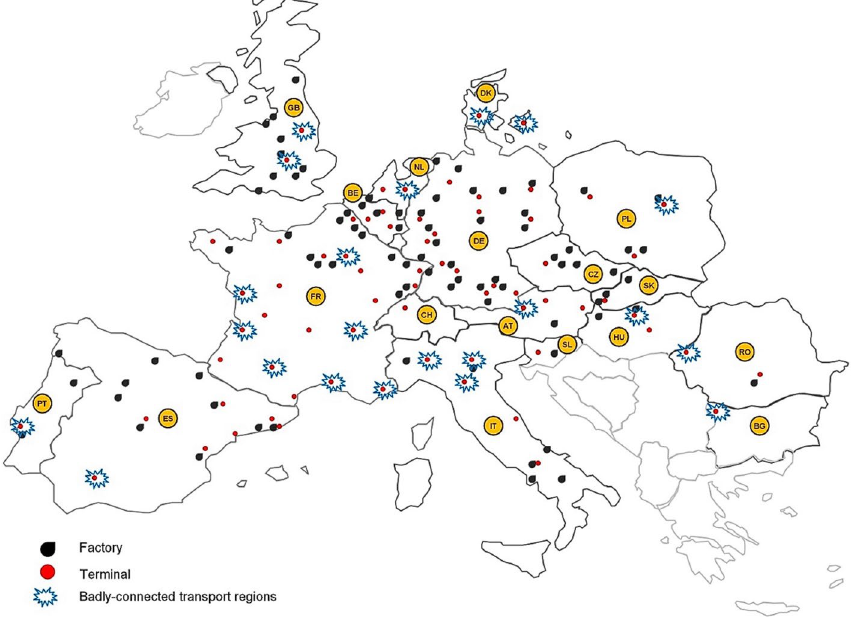
Fig. 4. Examined Transport model concept with badly-connected transport